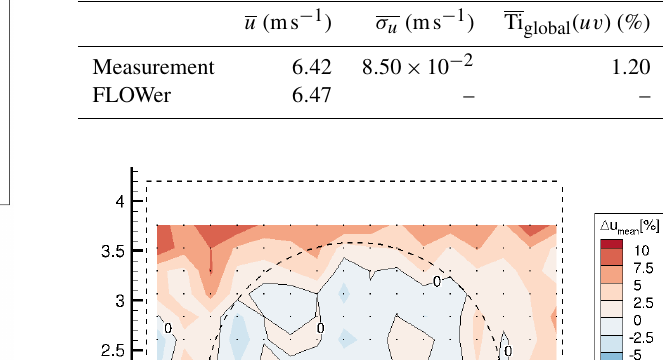
Table 5. Mean parameters for the velocity plane 0 . 43 d upstream of the rotor plane.